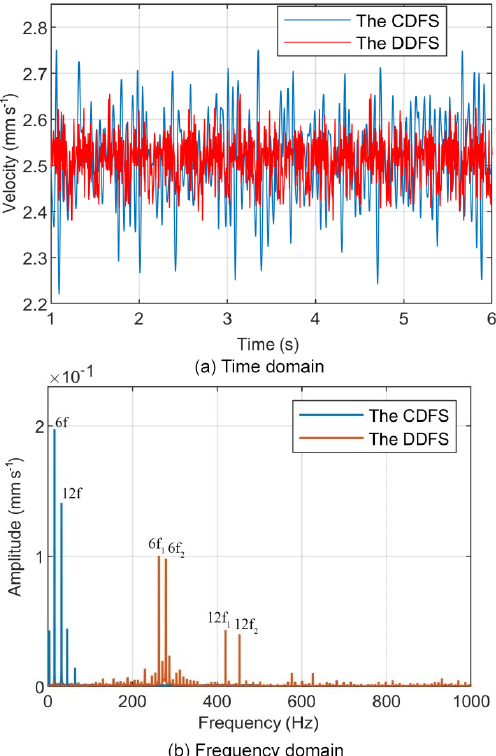
Figure 7. Comparison of the table velocity fluctuations of CDFS and DDFS when the nut servo motor speed is 500rpm in the DDFS.